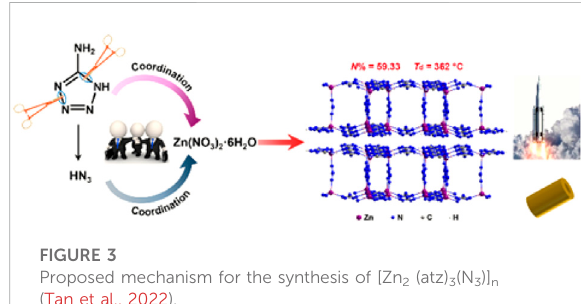
FIGURE 3 Proposed mechanism for the synthesis of [Zn 2 (atz) 3 (N 3 )] n (Tan et al.,